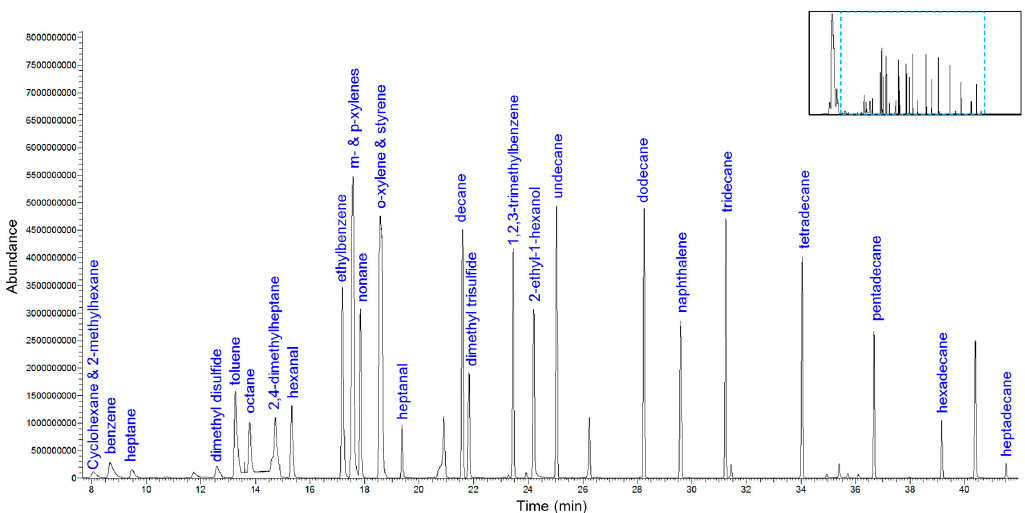
Figure 2. Total ion current chromatogram of the volatiles reference mix (VRM) 1 and the saturated alkanes mix (SAM) 1 using carbon wide range (CWR)/polydimethylsiloxane (PDMS) solid-phase microextraction (SPME) Arrow.